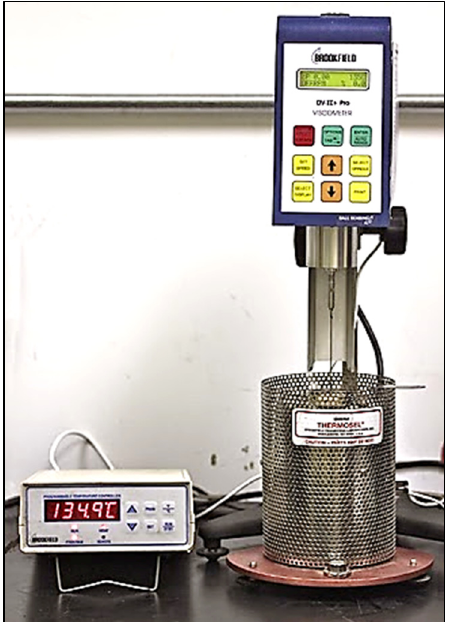
Figure 6. Rotational Brookfield viscometer.